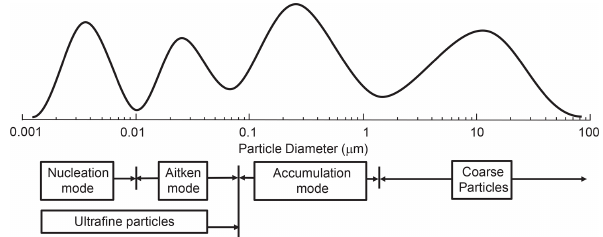
Figure 1. An example of a particle size distribution consisting of a number of different modes. The names of the different modes and sizes are